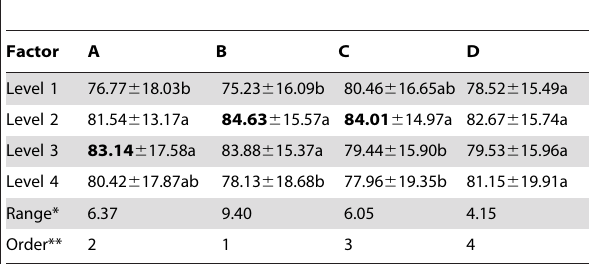
Table 3. Average responses of each level and range of Germination percentage (%). N= 40.